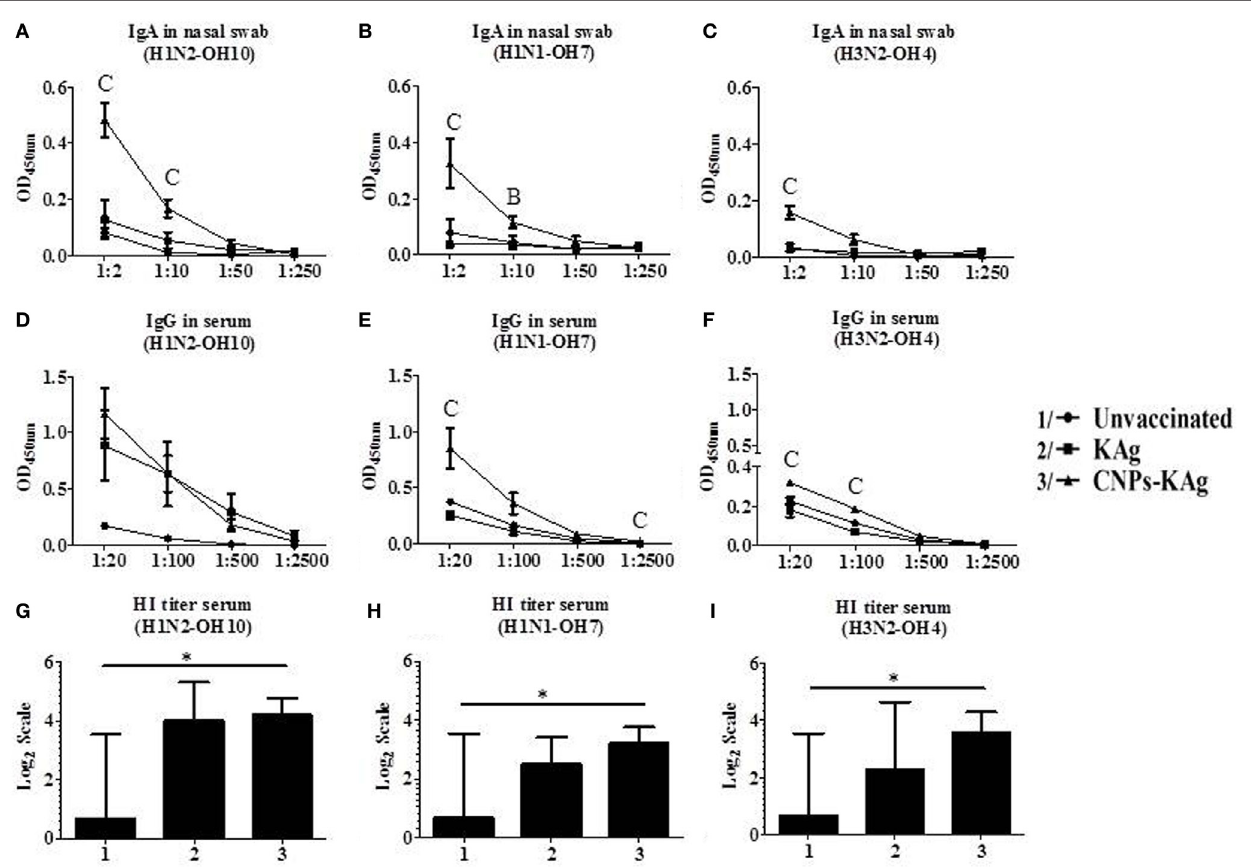
FigUre 3 | Antibody response after chitosan nanoparticles (CNPs)-KAg prime-boost vaccination at day post-vaccination 35/day post-challenge 0 (DPV 35/DPC 0) in pigs. Mucosal secretory IgA antibody response in nasal swab, systemic IgG antibody, and hemagglutination inhibition (HI) titers in serum samples against (a,D,g) H1N2-OH10, (B,e,h) H1N1-OH7, and (c,F,i) H3N2-OH4 influenza A virus (IAVs). Data represent the mean value of three to five pigs ± SEM. Statistical analysis was carried out using Kruskal–Wallis test followed by Dunn’s post hoc test. Asterisk refers to statistical significant difference between the indicated two pig groups (* p < 0.05). In antibody dilution curves (a–F) , A, B, and C refer to significant difference between unvaccinated vs KAg vaccinates, unvaccinated vs CNPs-KAg vaccinates, and KAg vs CNPs-KAg vaccinates, respectively, at the indicated